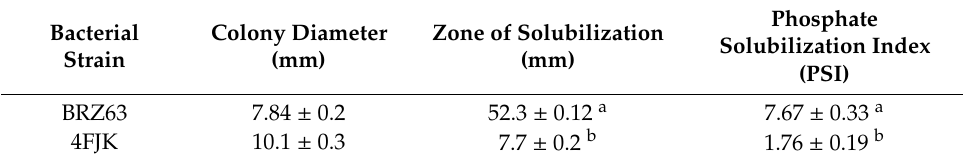
Table 2. Qualitative estimation of the phosphate solubilization e ffi ciency of P. fluorescens BRZ63 and the control Enterobacter asburiae 4FJK strain.